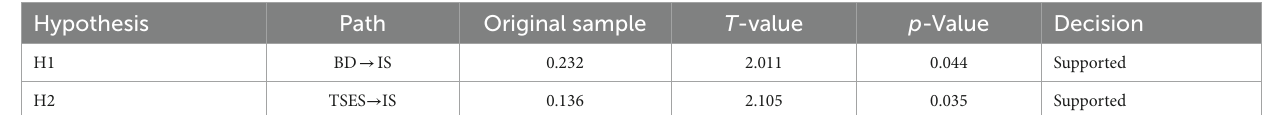
TABLE 5 Inner model